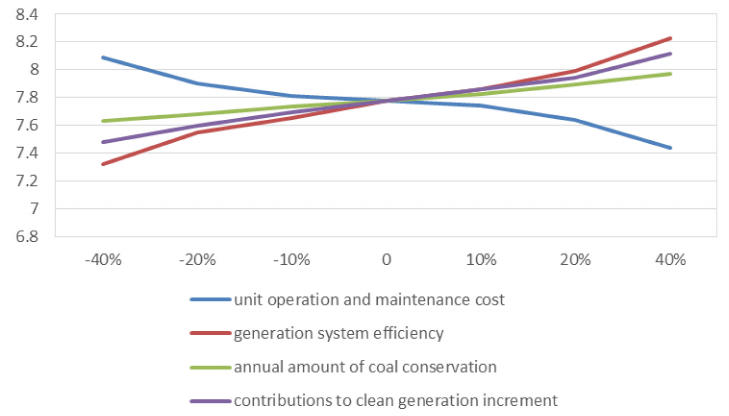
Figure 8. Sensitivity analysis results of index weighting on project